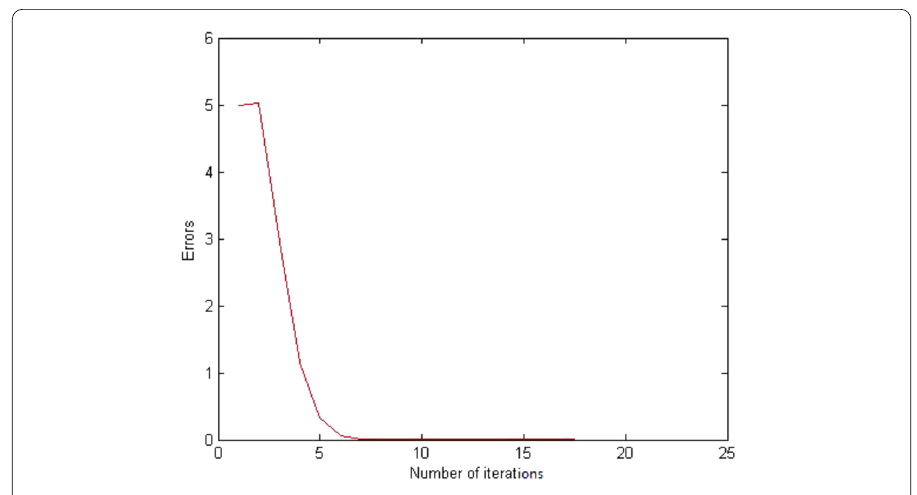
Figure 2 The values of errors given in Table